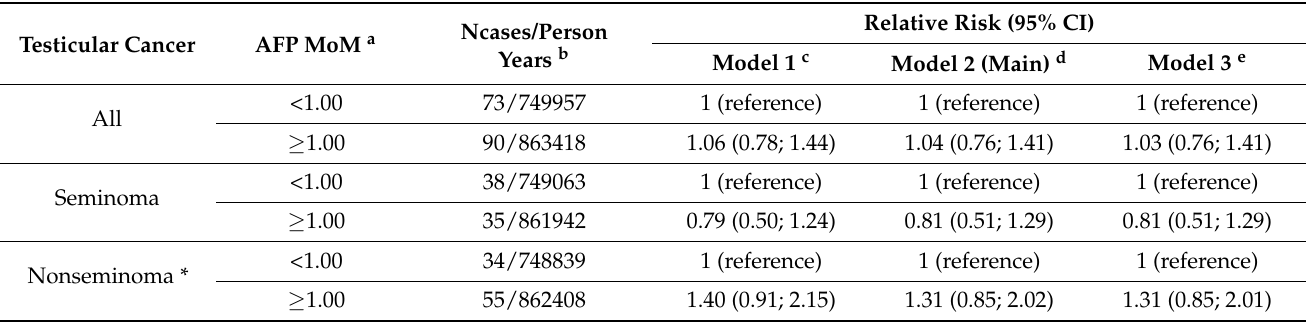
Table 2. Relative risk (RR) of testicular cancer in male offspring according to serum levels of α - fetoprotein (AFP) during the second trimester of pregnancy.